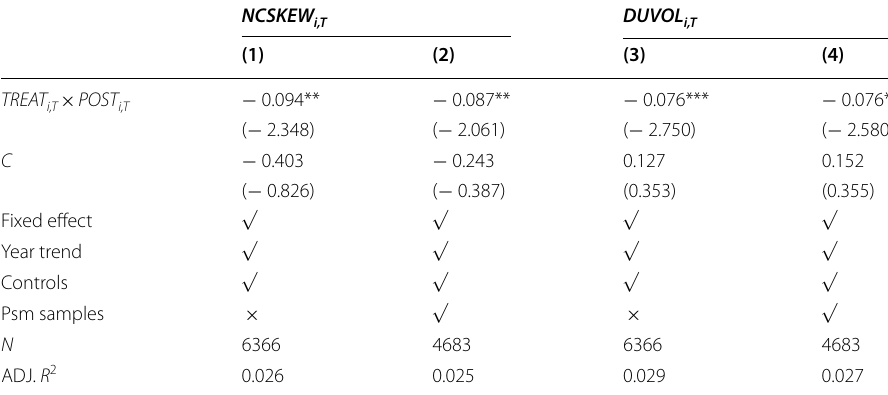
Table 6 CETS impact on the stock price crash